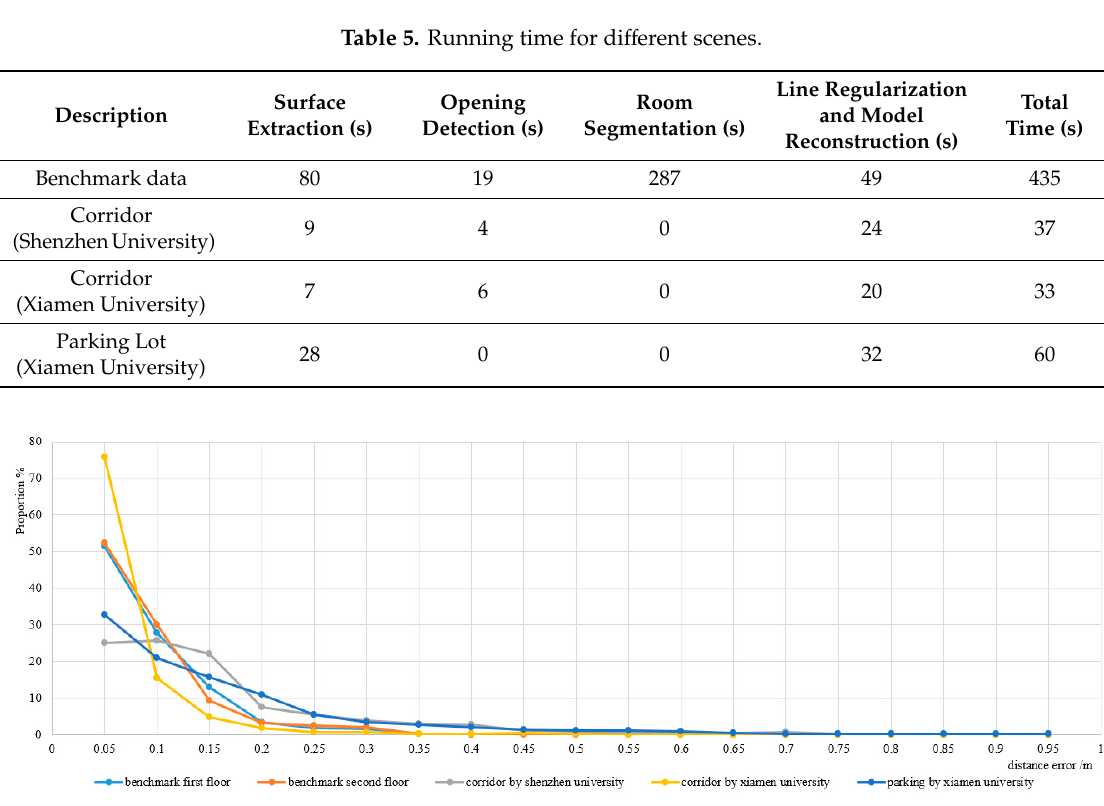
Figure 23. Euclidean distance deviation distribution map.